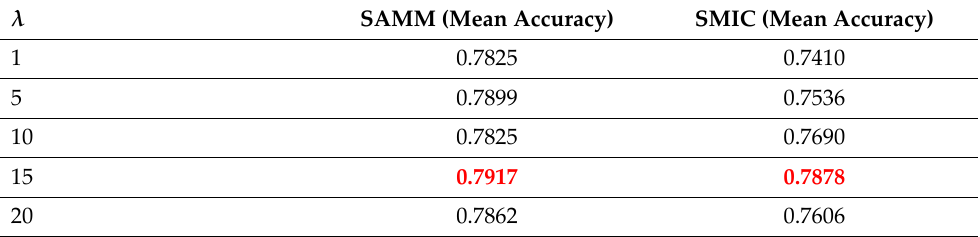
Table 10. Performance of DS‑3DCNN (with domain adaptation) with different λ in the loss function.